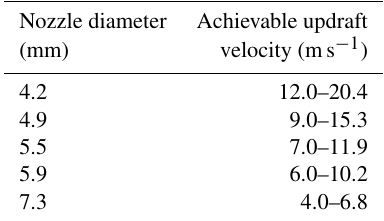
Table 1. Inlet nozzle diameters vs. nozzle velocity